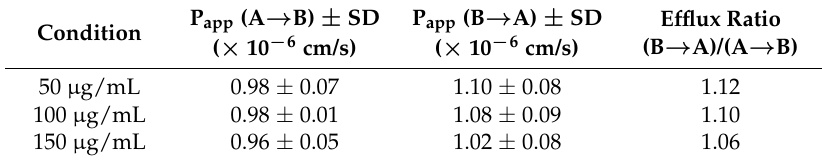
Table 1. Various concentrations of aspirin transport across Caco-2 cell monolayers.